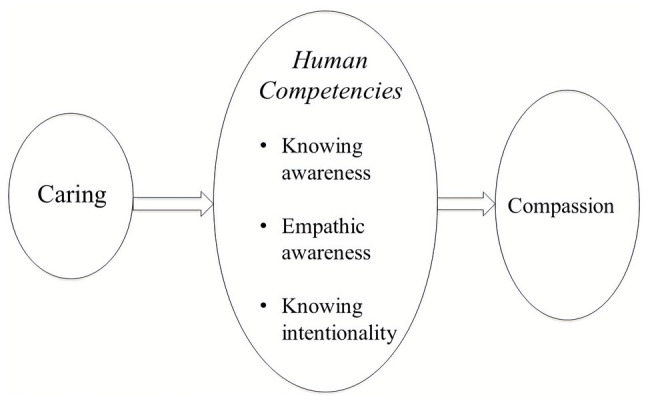
From caring to compassion. Adapted from Gilbert (2018).